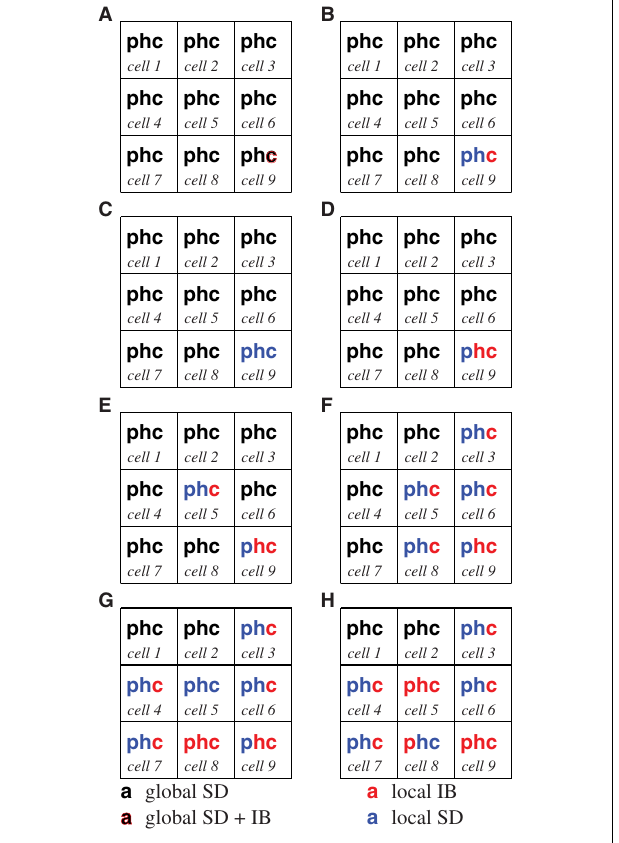
figurations: each of the alternative configurations (including “efficient” configurations. The configuration of cell 9, ˇ τ 6